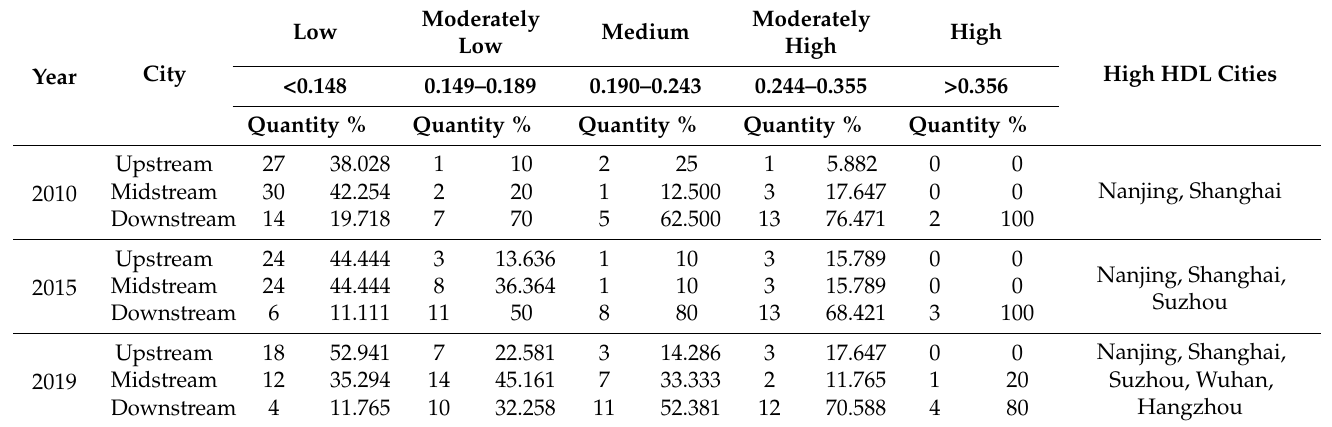
Table 3. HDL of cities in the YREB in 2010, 2015, and 2019.